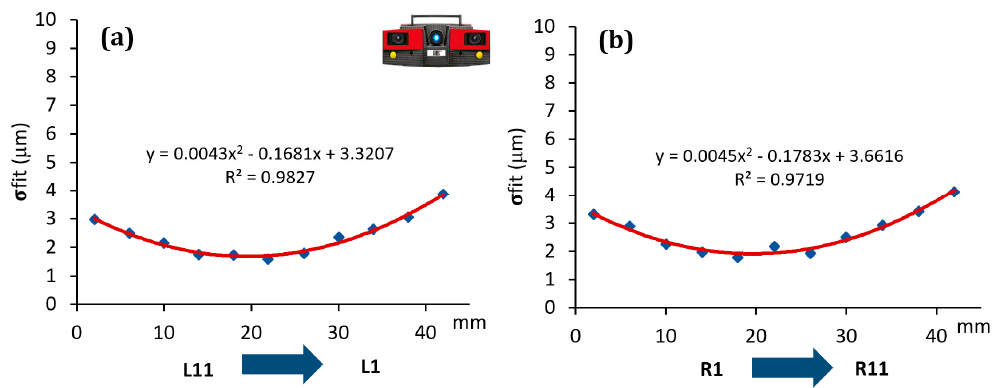
Figure 7. Trend of the sigma fitting error ( σ fit) evaluated considering the distance from the sensor for SLS scanner. Left groove sides ( a ) and right groove sides ( b ).